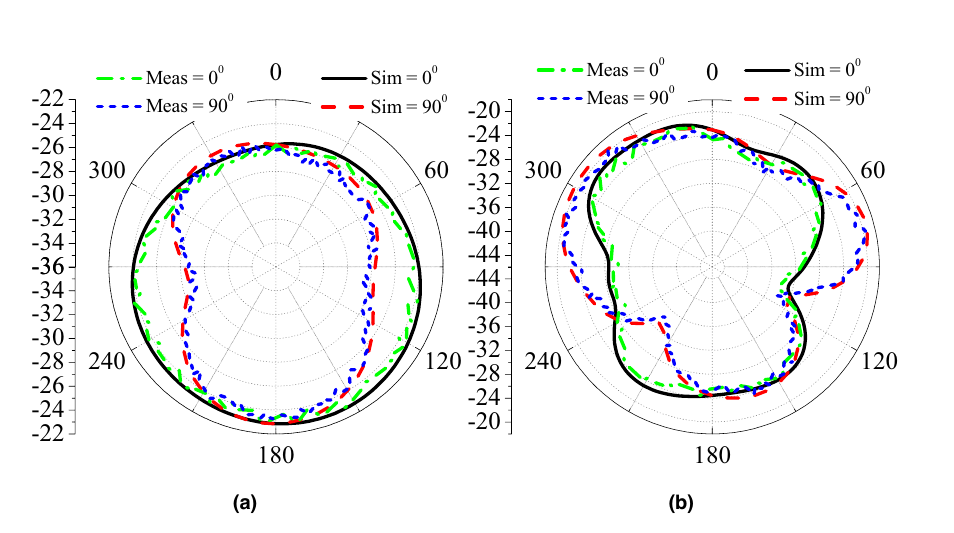
Figure 12. Radiation patterns of the antenna at ( a ) 915 MHz and ( b ) 2.45